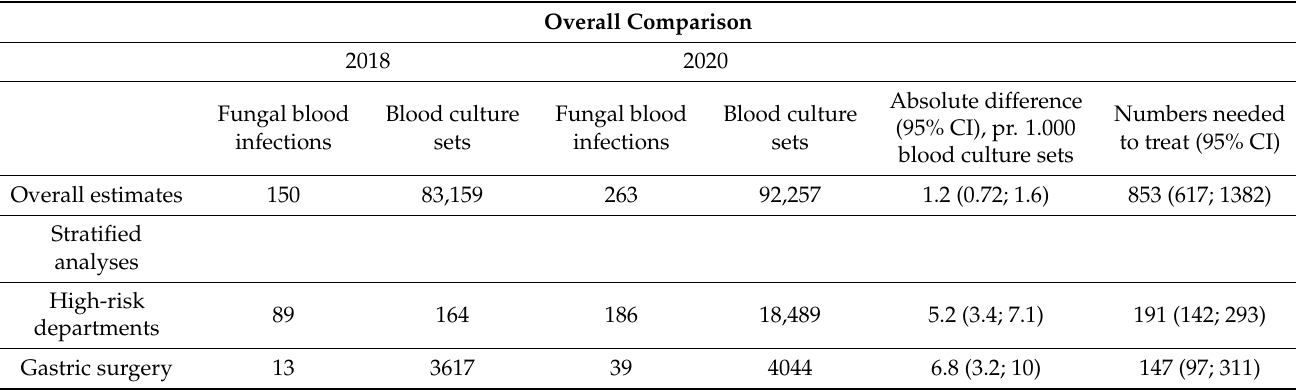
Table 3. Overview of candidemia’s in the cohort. Absolute difference and numbers needed to